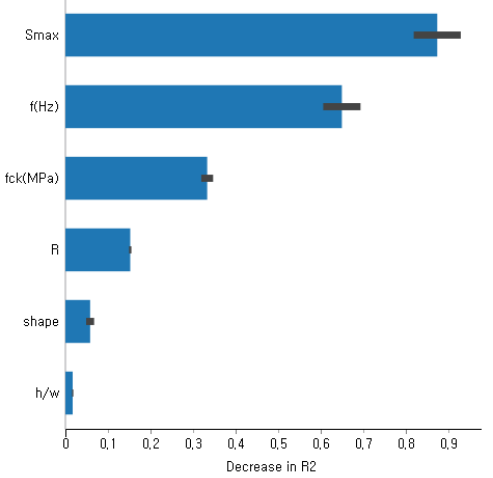
Figure 16. Permutation feature importance of the gradient boosting Figure 16 . Permutation feature importance of the gradient boosting model.